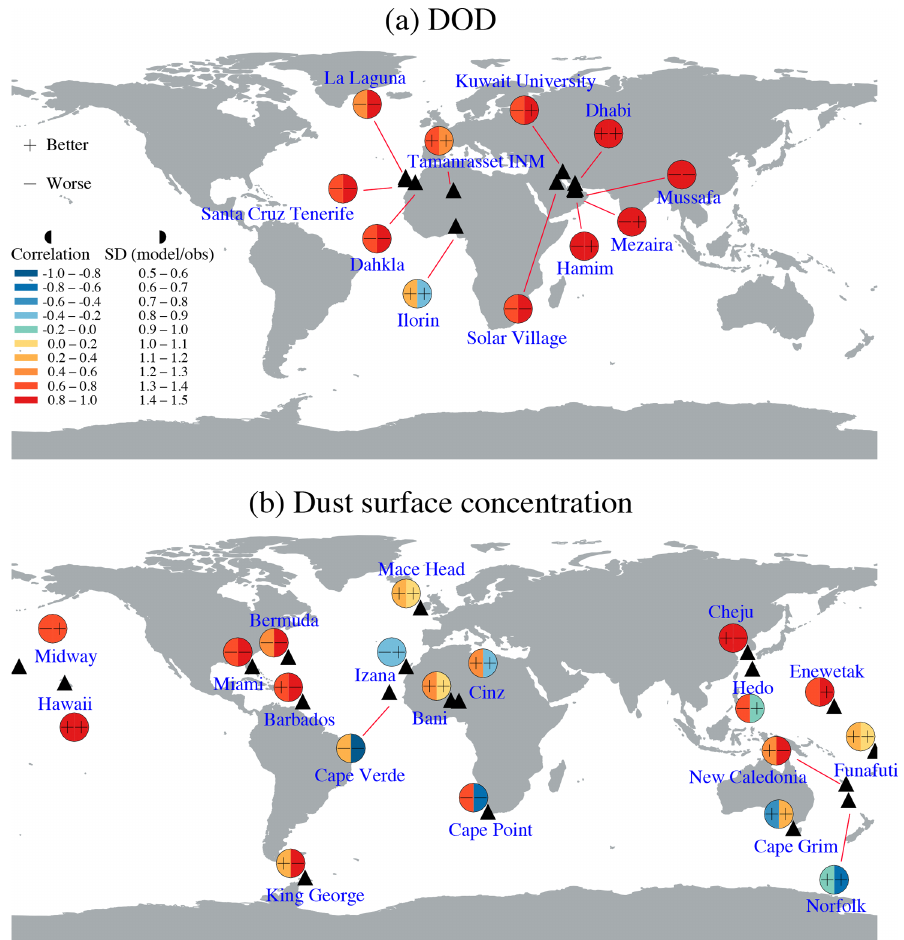
Figure 4. Modeling performance for the seasonal cycle of DOD (a) and dust surface concentrations (b) by CAM6. α (new model) against in situ (site names listed in the figure) measurements, relative to the performance of CAM6.1 (default model) against in situ measurements (improvement, degradation, no change indicated by “ + ”, “ − ”, and none characters, respectively). Colored left and right semi-circles represent Kendell’s τ coefficient between CAM6. α and observations and the ratio of standard deviation (CAM6. α over observation; each normalized by annual mean values),